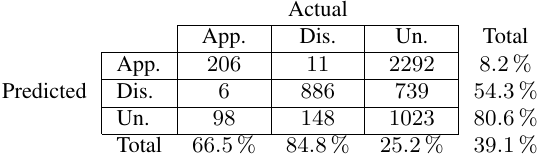
Table 1. The confusion matrix determined by evaluating the Delta Octree with a 2m resolution.